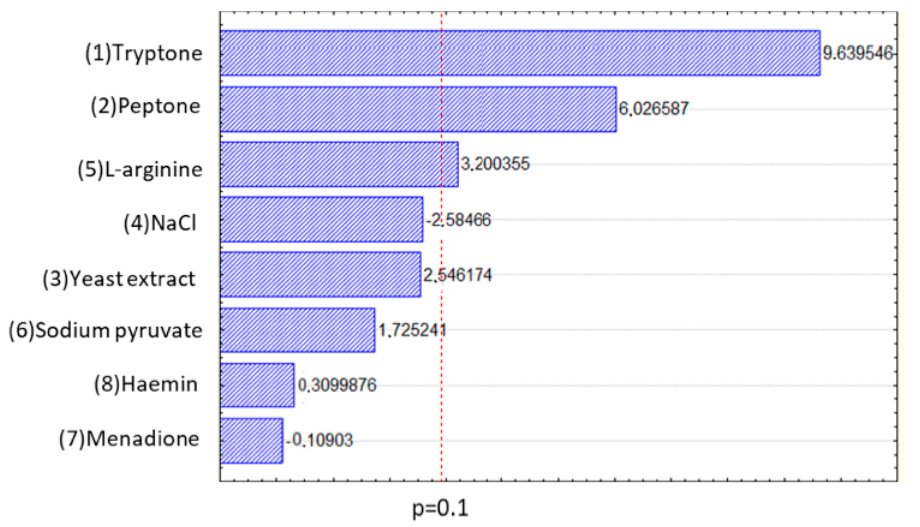
Figure 1. Pareto diagram for the estimated effect of each variable of the Placket–Burman design for C. carboxidivorans syngas fermentation with 1 g/L glucose: maximum ethanol production. The point at which the effects estimates were statistically significant (at p = 0.1) is indicated by the broken vertical line.